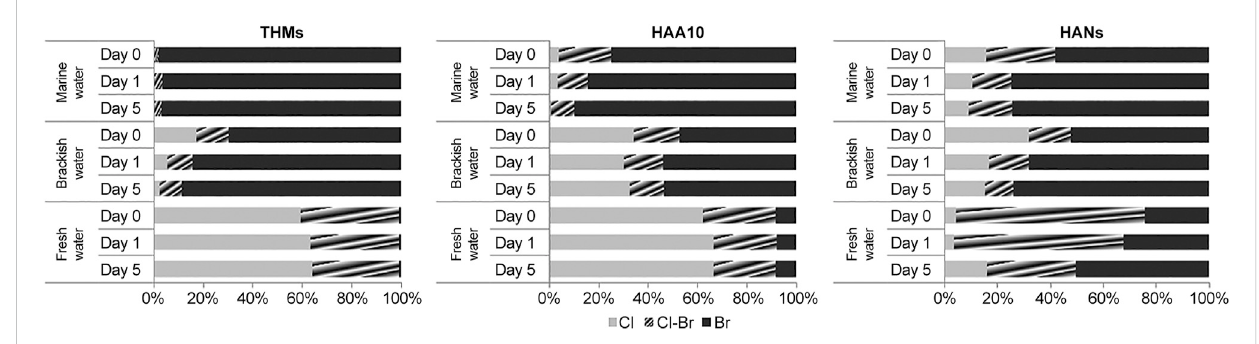
Compositional patterns of DBPs in treated water according to chlorinated and brominated